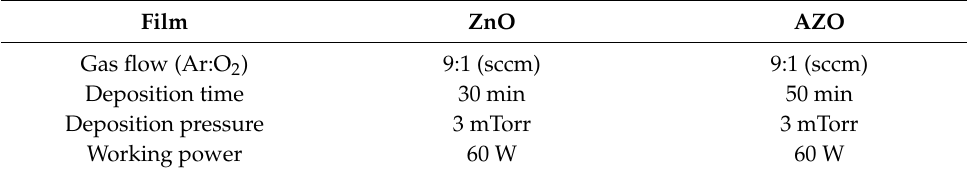
Table 2. The sputtering parameters of the sensing films.